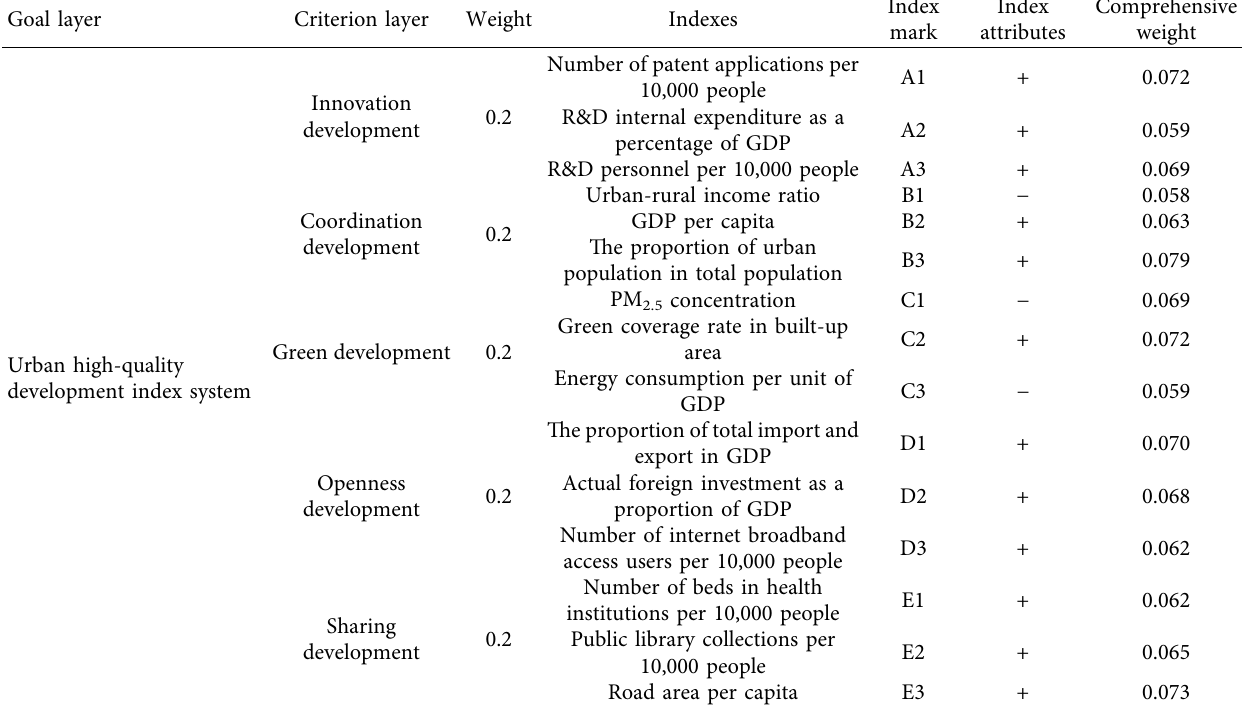
Table 1: Evaluation system of urban high-quality development.